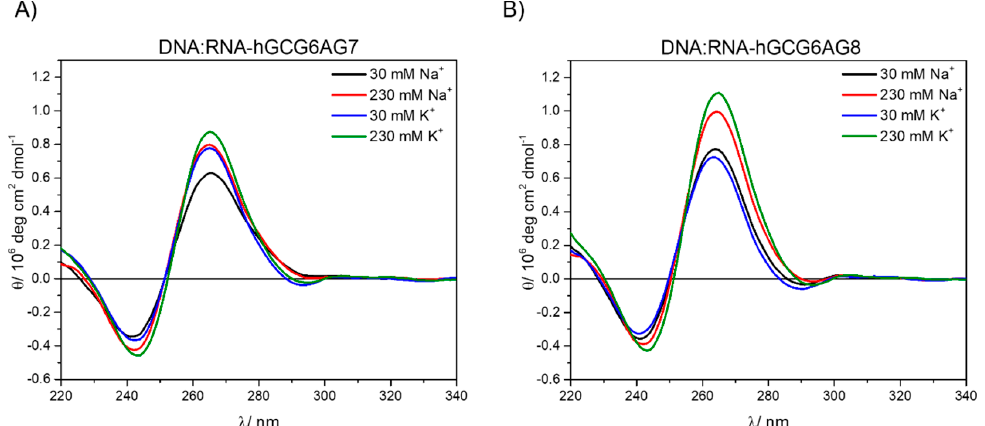
Figure 6. CD spectra of the hybrids DNA:RNA-hGCG6AG7 ( A ) and DNA:RNA-hGCG6AG8 ( B ) in a phosphate buffer at different concentrations of sodium and potassium after removing the contribution of non-G4 DNA (see Supplementary Figure S5).